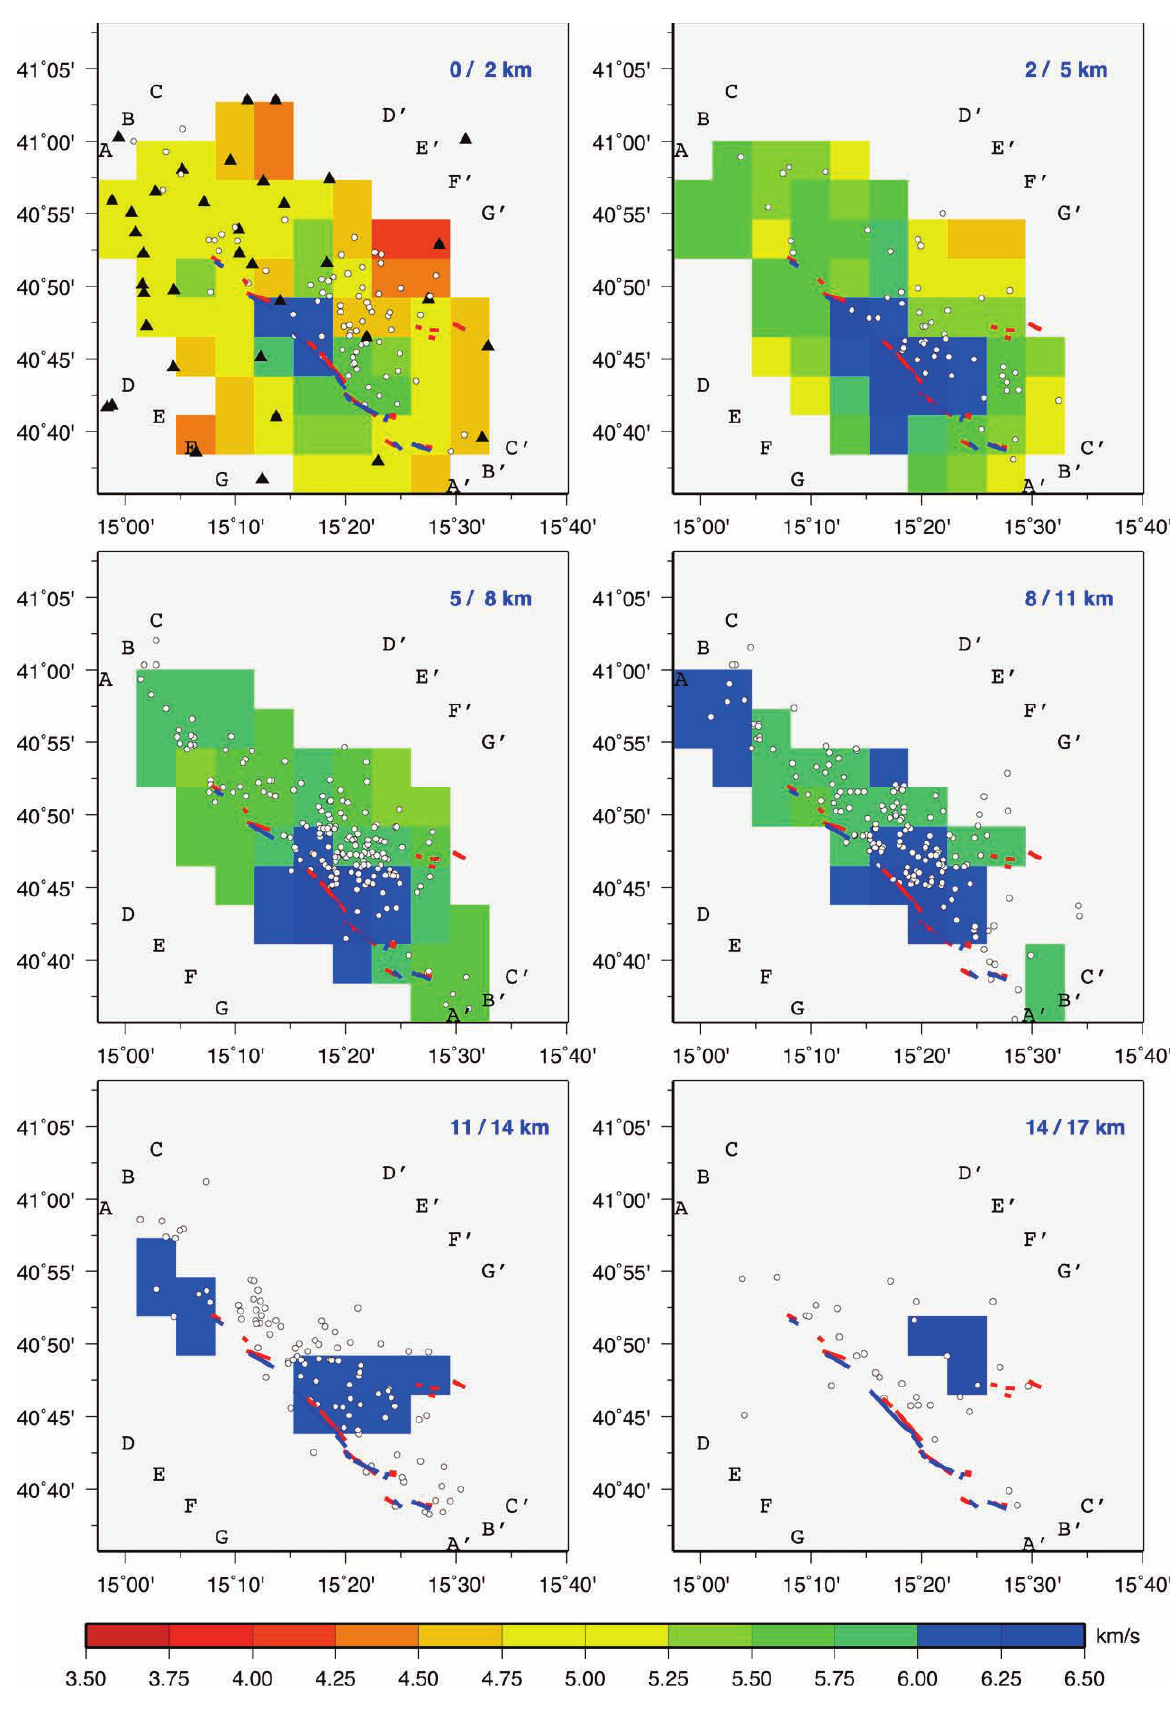
Figure 8. P-wave velocity models obtained from travel-time inversions for a 5-5-3 km grid, giving a layer thickness of 3 km. Reported depth range in the upper-left plot is 0-2 km because of the presence of topography, characterized by an average elevation of 1 km. Black triangles, seismic stations; open circles, aftershock hypocenters for each layer; blue thick solid lines, fault scarps identified by Pantosti and Valensise [1990]; red thick solid lines, fault scarps identified by Blumetti et al. [2002]. Letters from A to G and A’ to G’ indicate the start and end points of the profiles reported in Figure